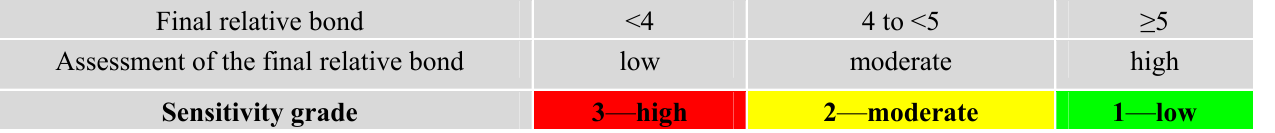
Table 4. Final assessment of sensitivity A.